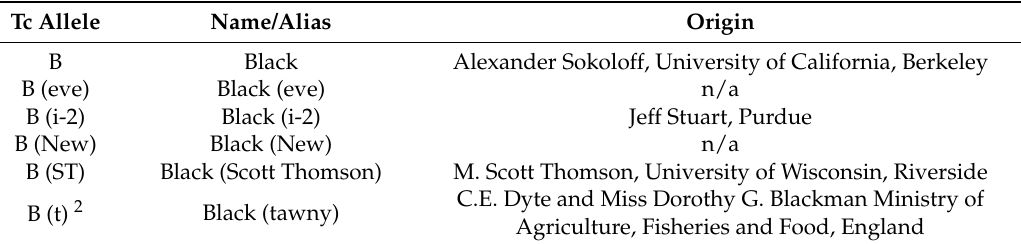
Table 2. Strains of T. castaneum with a black phenotype, all mapped to